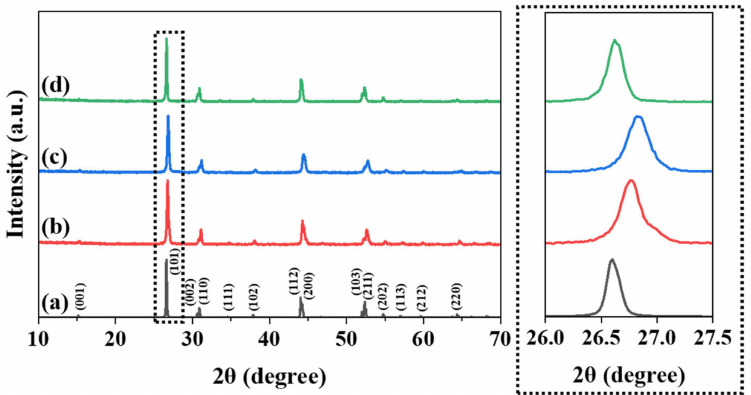
Figure 3. The calculated XRD patterns of ( a ) LaO 0.65 F 1.7 (ICSD 40371) and the obtained XRD patterns of La 1 − p − q Bi p Tb q O 0.65 F 1.7 phosphors ( b ) q = 0.01; ( c ) q = 0.1; ( d ) p = 0.01 and q = 0.1. Figure4ashowstheexcitationandemissionspectraofLa 0.99 Bi 0.01 O 0.65 F 1.7 , La 0.9 Tb 0.1 O 0.65 F 1.7 , and La 0.89 Bi 0.01 Tb 0.1 O 0.65 F 1.7 phosphors [6]. Previously, the photoluminescence properties of Bi 3+